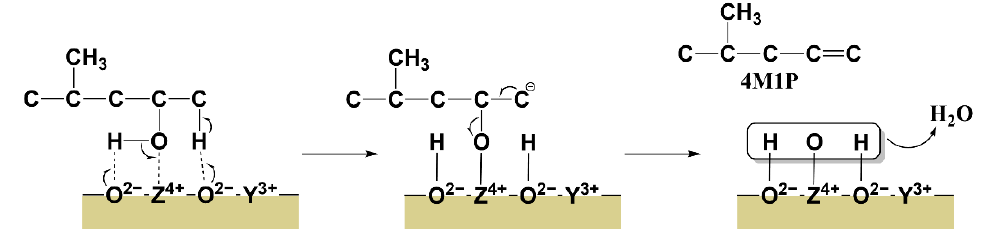
Figure 9. Plausible reaction mechanism on the conversion of 4M2Pol into 4M1P via E1cB pathway over the YSZ catalyst.